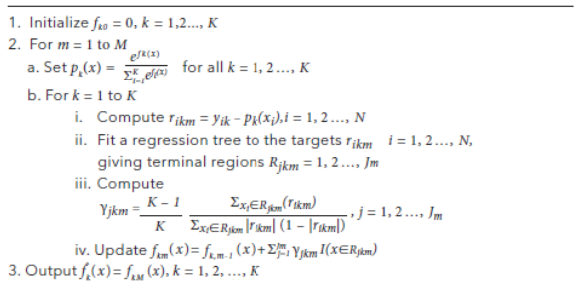
Figure 3. The proposed